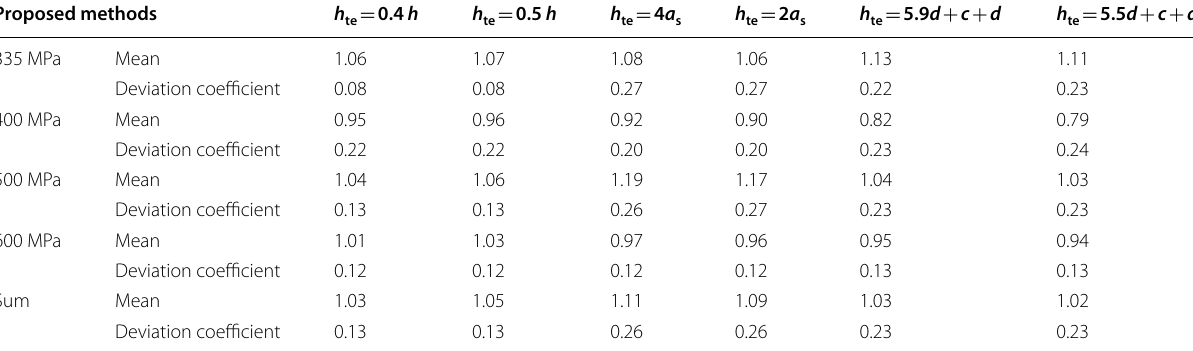
with calculated l cc c